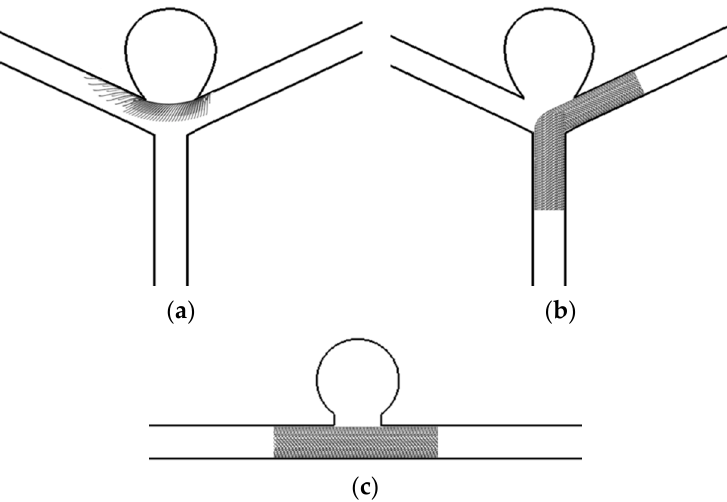
bifurcation, ( b ) PED in bifurcation, and ( c ) PED in sidewall configuration.